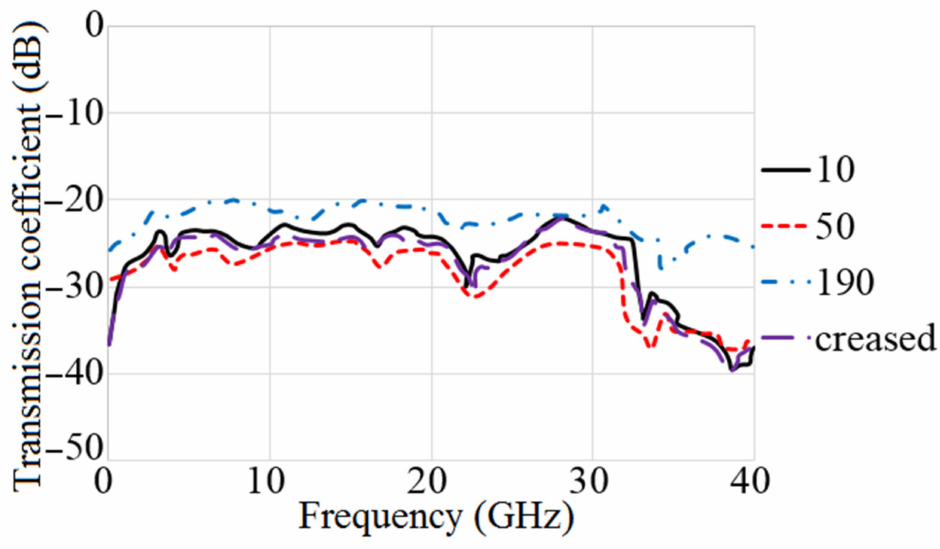
Figure 26. Transmission coefficient results of flexibility investigation for the proposed 8 ports UWB-MIMO (in degrees) when antenna 1 sends.